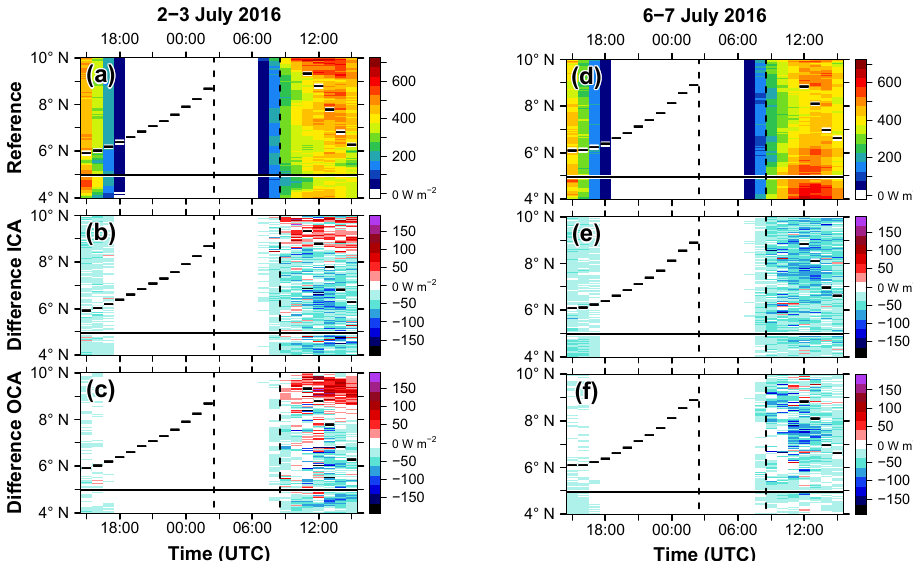
Figure 9. Hovmöller diagram of SSR and SSR difference (Wm − 2 ) for (a, d) the reference, (b, e) reference minus No-ALWC for ICA and (c, f) reference minus No-ALWC for OCA as a zonal mean over the Ivory Coast (7.5–3 ◦ W, 4–10 ◦ N) (left) between 2 July 15:00UTC and 3 July 15:00UTC and (right) between 6 July 15:00UTC and 7 July 15:00UTC. The horizontal bars denote the zonal mean location of the 302K isentrope at 250ma.g.l. of the reference, the horizontal solid line the zonal mean coastline and the vertical dashed lines the three phases introduced in Fig. 3.